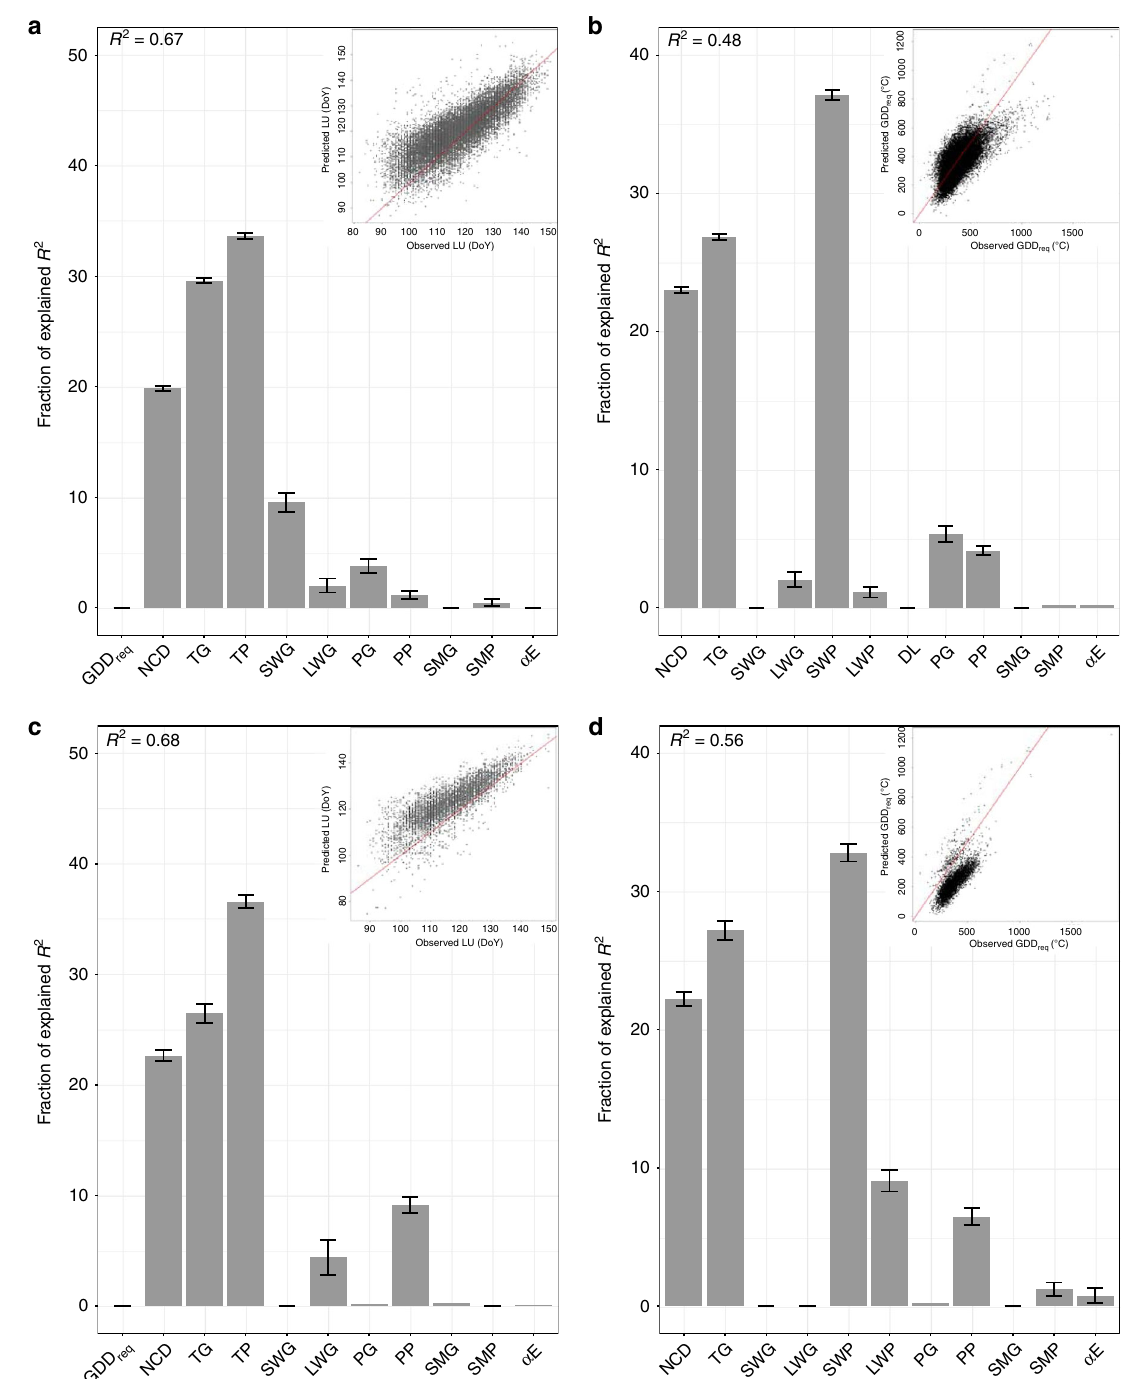
Fig. 1 Effect of background climate on LU and GDD req . Relative importance (%) of each variable in estimating (a ) observed LU date for all sites and species (n = 27790), (b ) GDD req for all sites and species, (c ) LU date for drought-prone sites (n = 5747) and (d ) GDD req for drought-prone sites. See the last row of Fig. 2a – d (ALL) for the direction of each effect. NCD, number of chilling days estimated as the number of days between 1 November in the previous year and the LU date with temperatures between 0 and 5 °C; TG, mean growing-season temperature; TP, mean pre-season temperature; SWG, mean growing- season shortwave [visible and near infrared] radiation; LWG, mean growing-season longwave [infrared] radiation; SWP, mean pre-season shortwave [visible and near infrared] radiation; LWP, mean pre-season longwave [infrared] radiation; PG growing-season total precipitation; PP, pre-season total precipitation; DL, day length at LU date; SMG, growing season soil-moisture content; SMP, pre-season soil-moisture content α E, ratio of actual to potential evapotranspiration. drought-prone sites were de fi ned as sites with long-term α E <0.9. Variables were selected based on penalized elastic net regression and corrected for spatial autocorrelation; the coef fi cient of determination ( R ²) of the selected models is given at the top of each panel. Error bars represent the 95% con fi dence interval. The sum of the relative importance equals 100% of R². The scatter plot in each panel represents modeled versus observed variables (LU or GDD req ) after correcting coef fi cients for collinearity and spatial autocorrelation. The red line represents the 1:1 line. Source data are provided as a Source Data fi